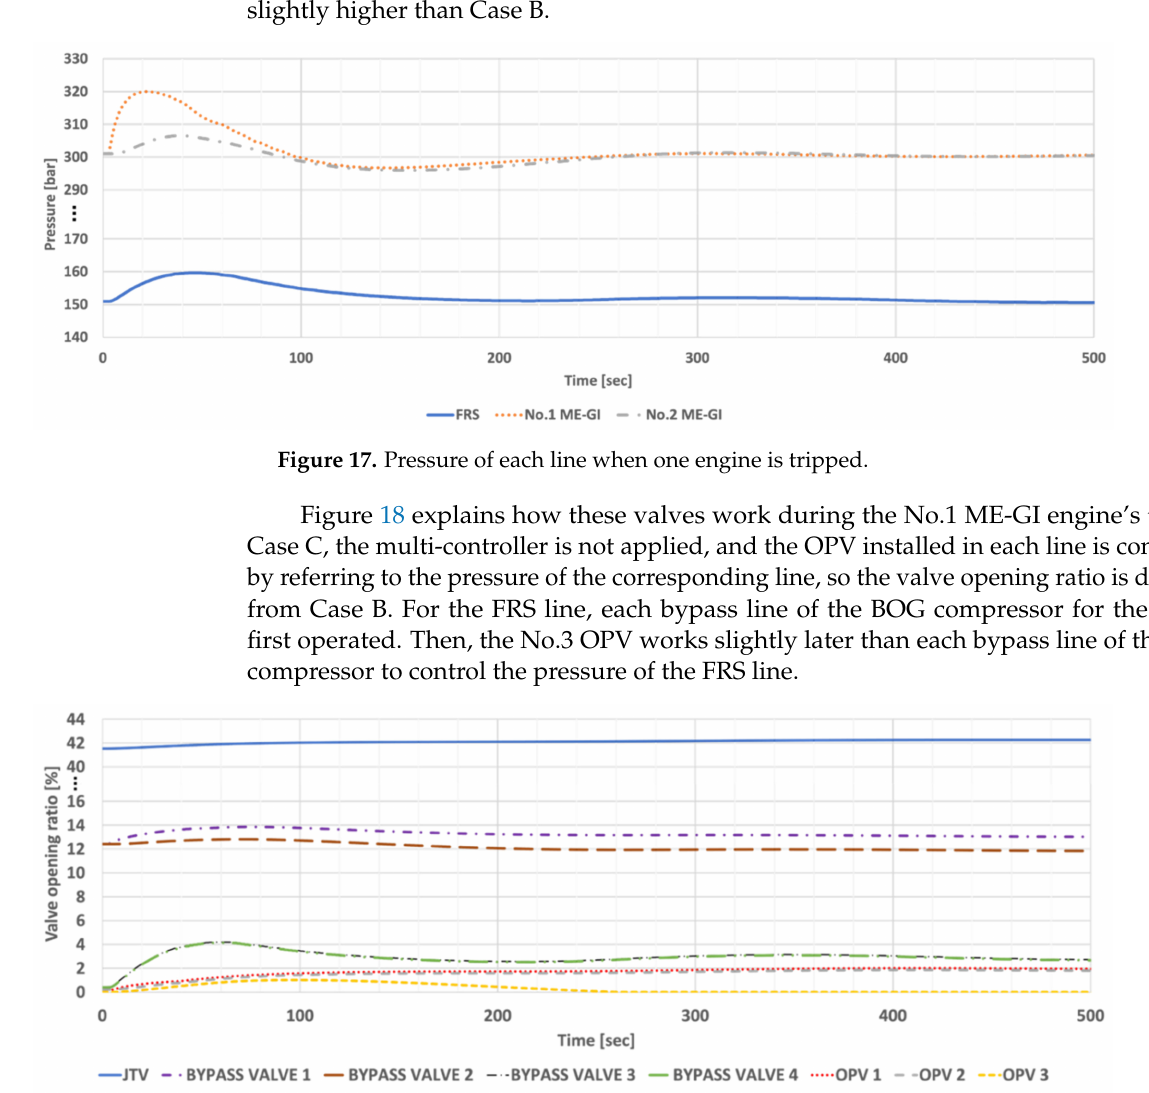
Figure 18. Valve opening ratio when one engine is